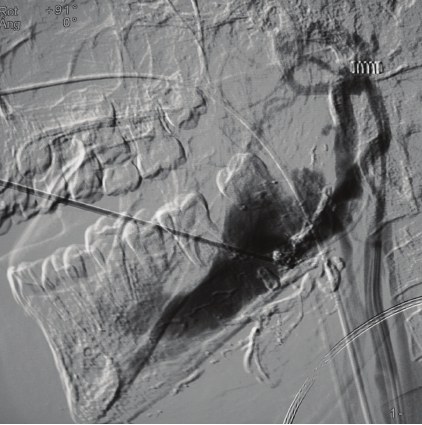
Figure 6: 8-year follow-up angio-CT.